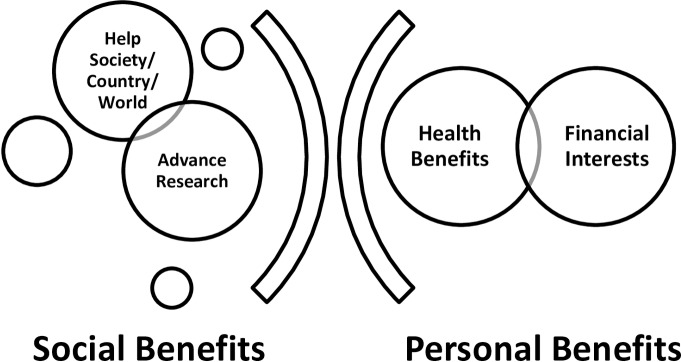
Motivation codes.